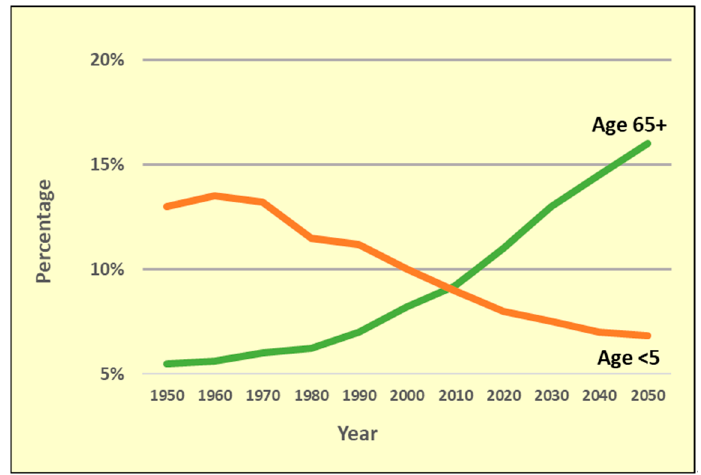
Figure 1. Young children and older people as a percentage of the global population [3].